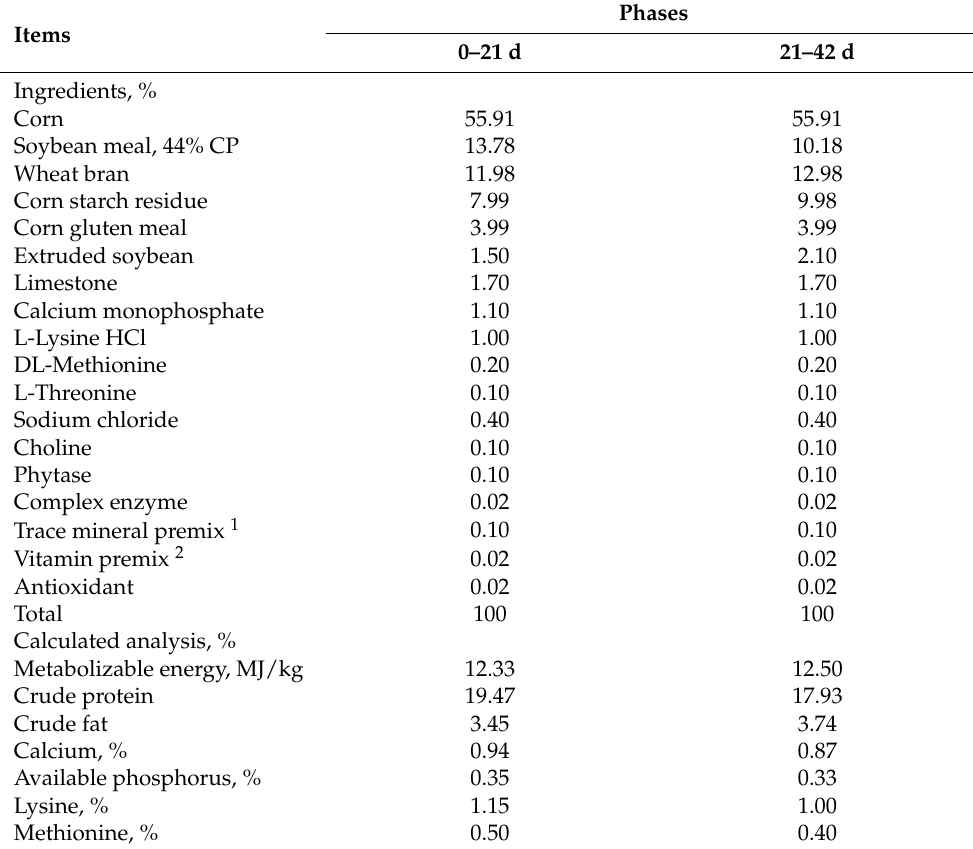
Table 1. Ingredients composition and nutrient levels of basal diets (as-fed